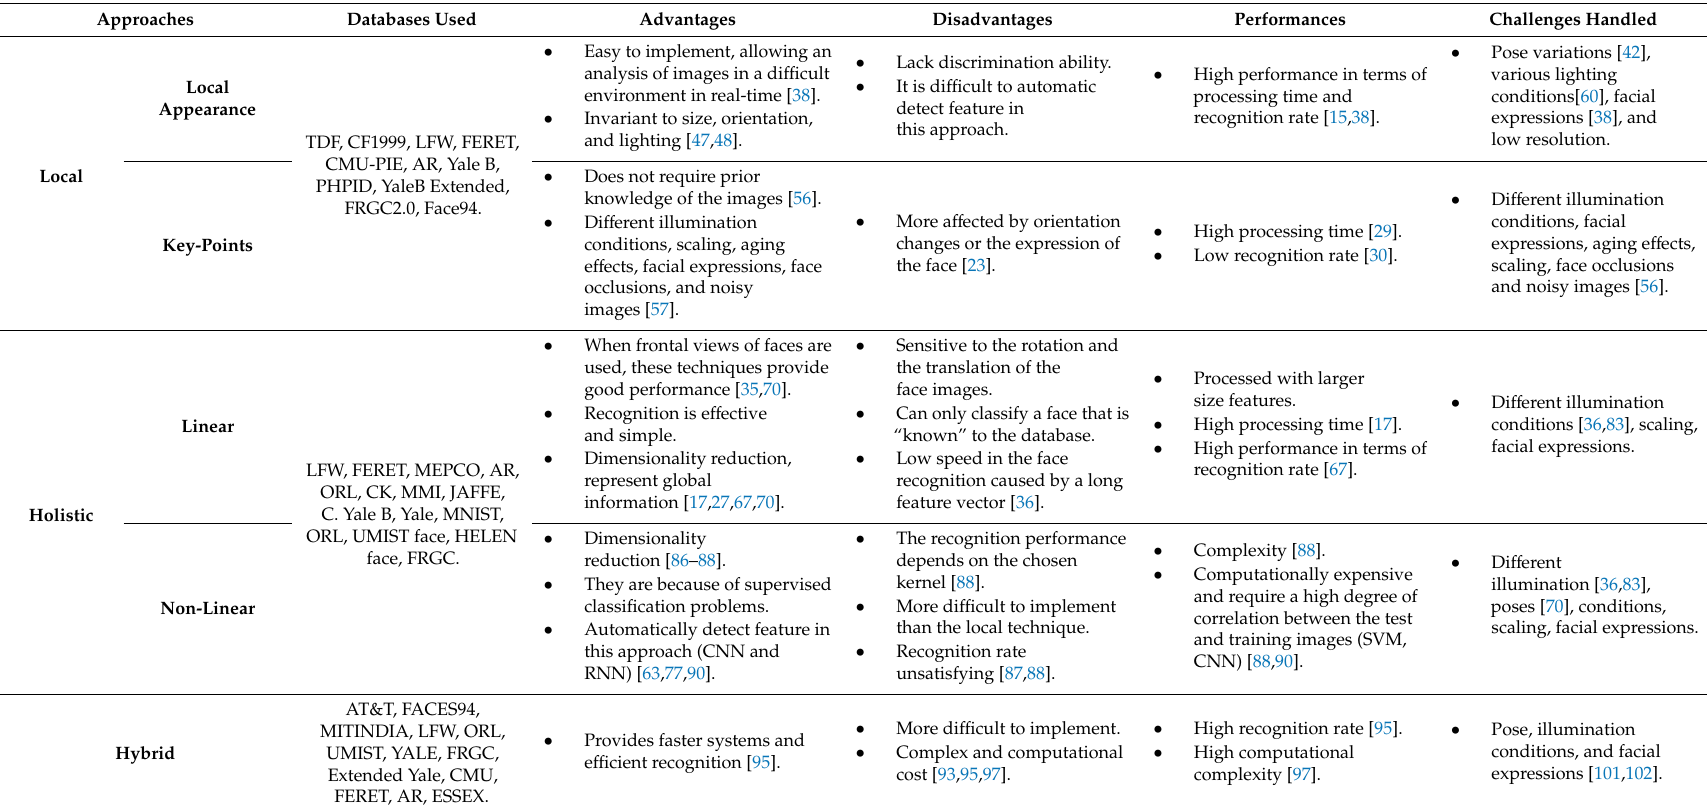
Table 4. General performance of face recognition